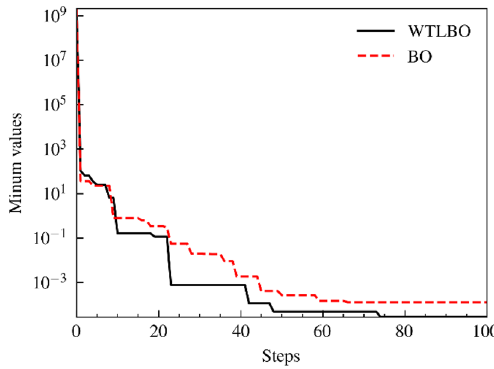
Fig. 8 Results of the WTLBO and BO on the parameterized quad- ratic function